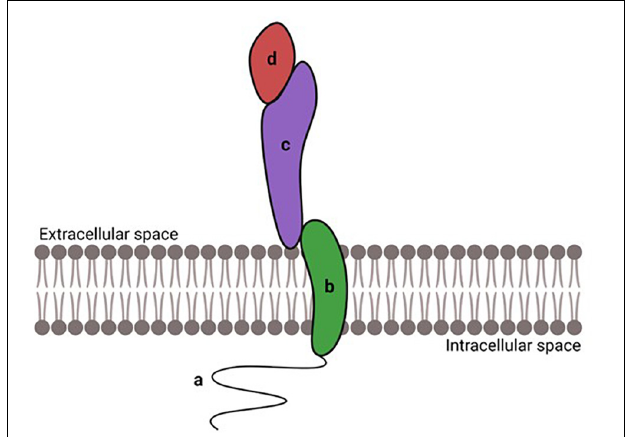
FIGURE 1 | Schematic structure of CAMs. CAMs have an intracellular domain (a) , a transmembrane domain (b) , and an extracellular domain (c) responsible for the binding to ligands (d) . Created with